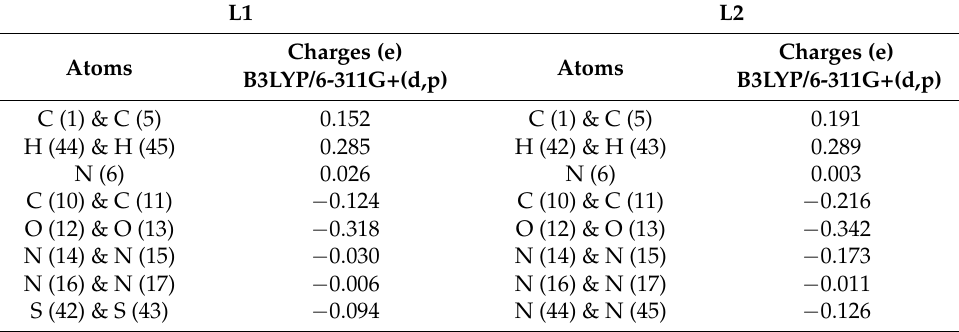
Table 1. Calculated values of Mullikan atomic charges. L1 L2 Charges (e) Atoms